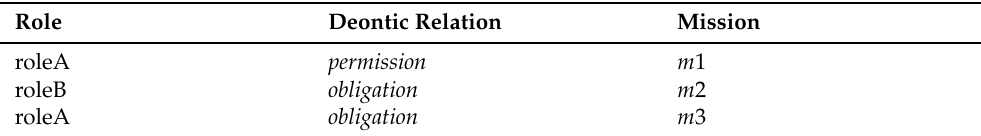
Table 1. M oise + deontic specification, based on